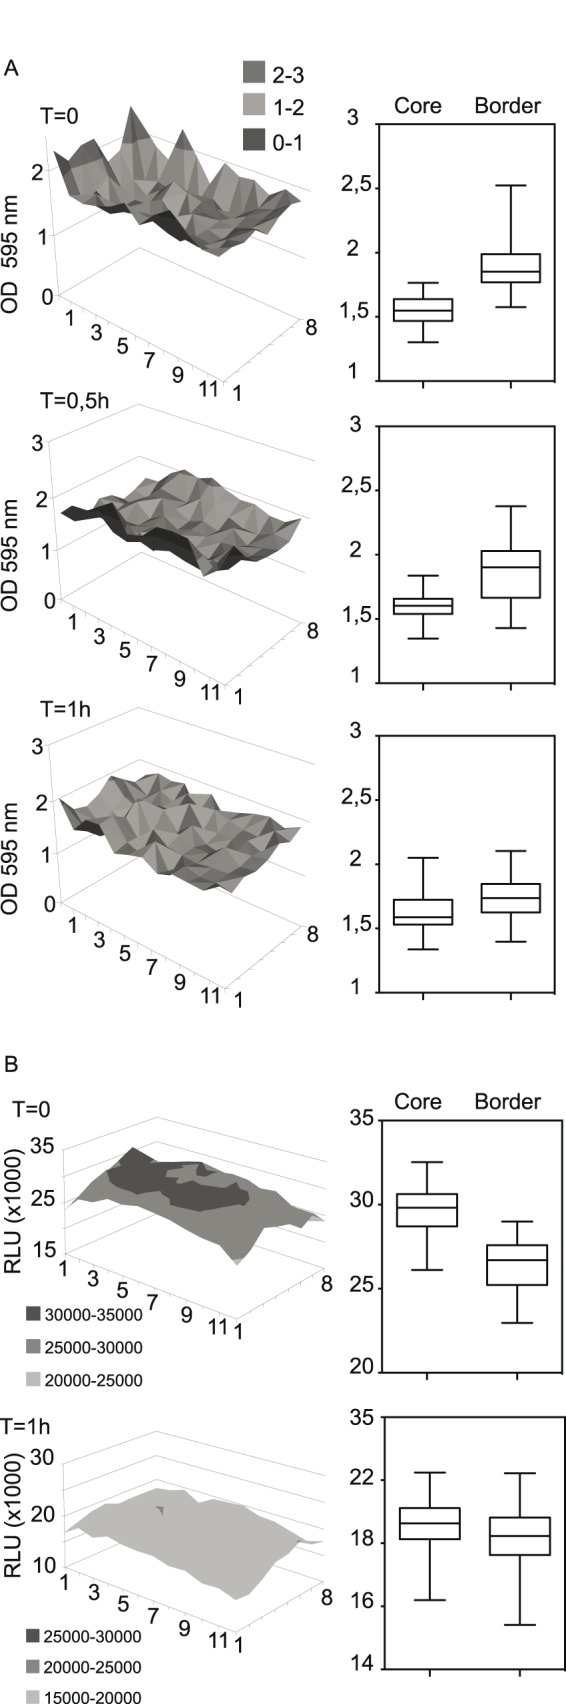
Edge effect reduction on cellular growth applied to the HT-29-PPARγ reporter cell-line.A Parental HT-29 cells were homogeneously seeded using a pipetting robotic workstation and pre-incubated at room temperature for the indicated time (0, 0.5 or 1 h) prior to 37°C incubation for 24 h. Cellular monolayer homogeneity was monitored using cell staining with crystal violet and quantified by absorption measurement at 595 nm. Left panel is a surface plot of a representative set of plates at increasing times of room temperature pre-incubation. Boxplot representation (right panels) of the OD 595 values for the border compared to the core of the respective representative plates. Mean p-values for different cell-lines tested are summarized in Table 1. B HT-29-PPARγ reporter cells were homogeneously seeded using a pipetting robotic workstation and pre-incubated at room temperature for the indicated time (0 or 1 hour) then at 37°C for 24 h prior to sodium butyrate (2 mM) activation. Luciferase activity (RLU) was quantified after 24 h of activation. Graph (left panels) shows two representative plates with different pre-incubation times at room temperature. Boxplots (right panels) represent the border and core values of the surface plots. Mean p-values for different cell-lines tested are summarized in Table 2.